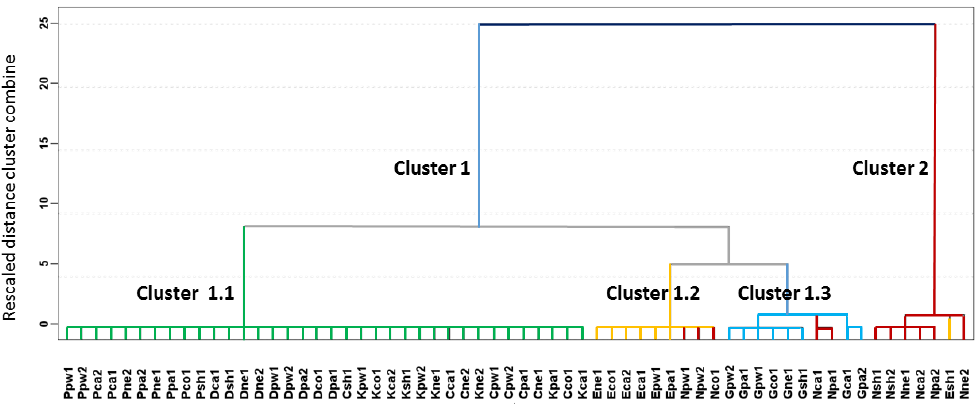
Figure 4. Dendrogram obtained from HCA for fire debris samples ( n = 63 ) using the MS data from E-Nose (45–200 m / z ).